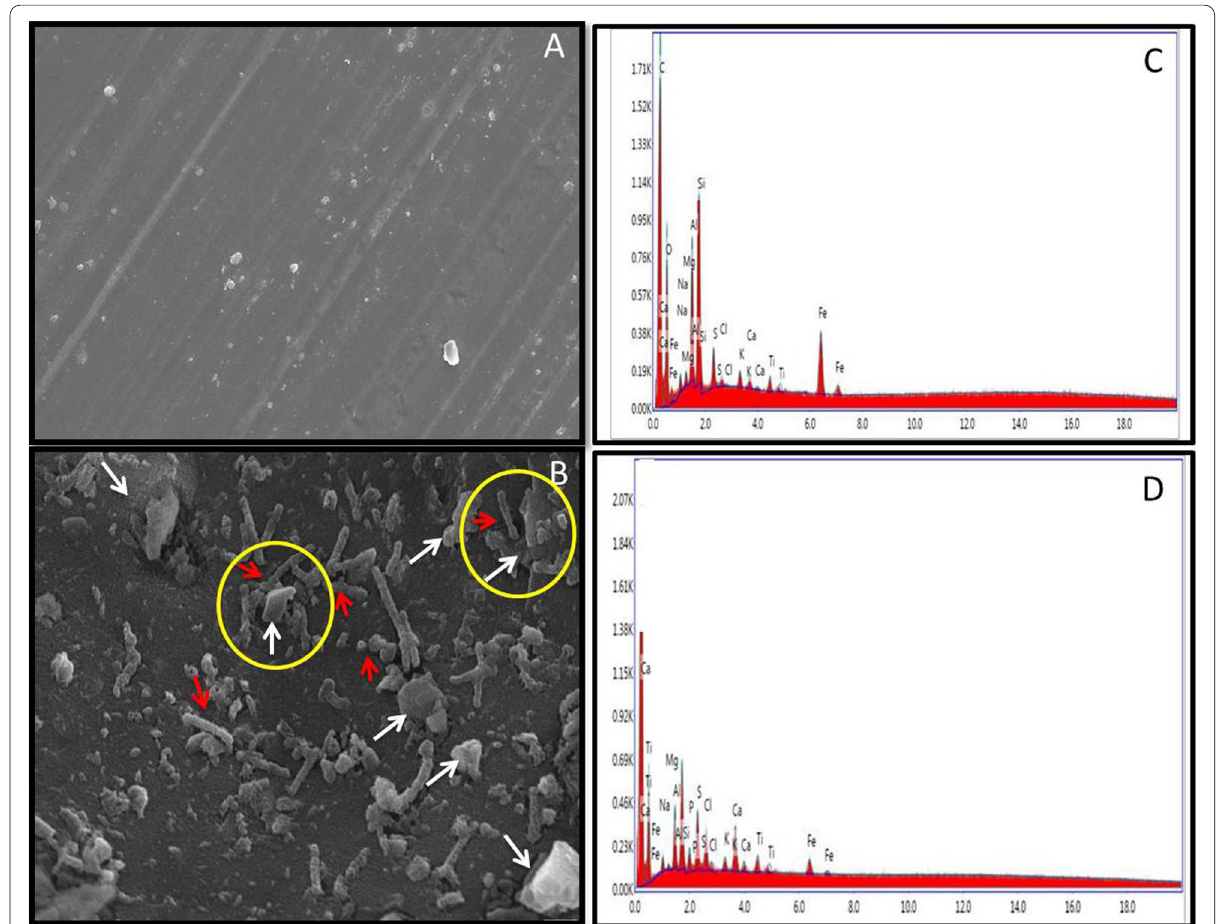
Fig. 8 A The untreated (before bacterial treatment) coal particles (scale bar 2 μm). B The treated (after bacterial treatment) coal particles (scale bar 2